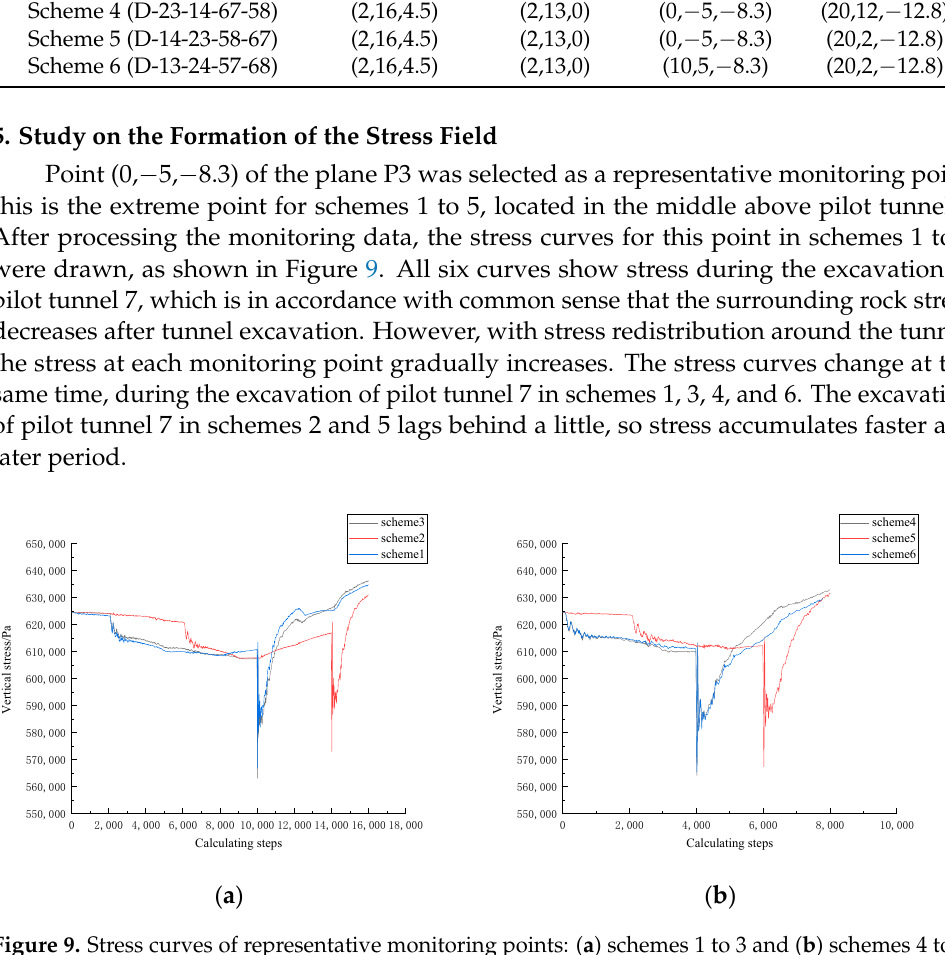
Figure 9. Stress curves of representative monitoring points: ( a ) schemes 1 to 3 and ( b ) schemes 4 to 6.